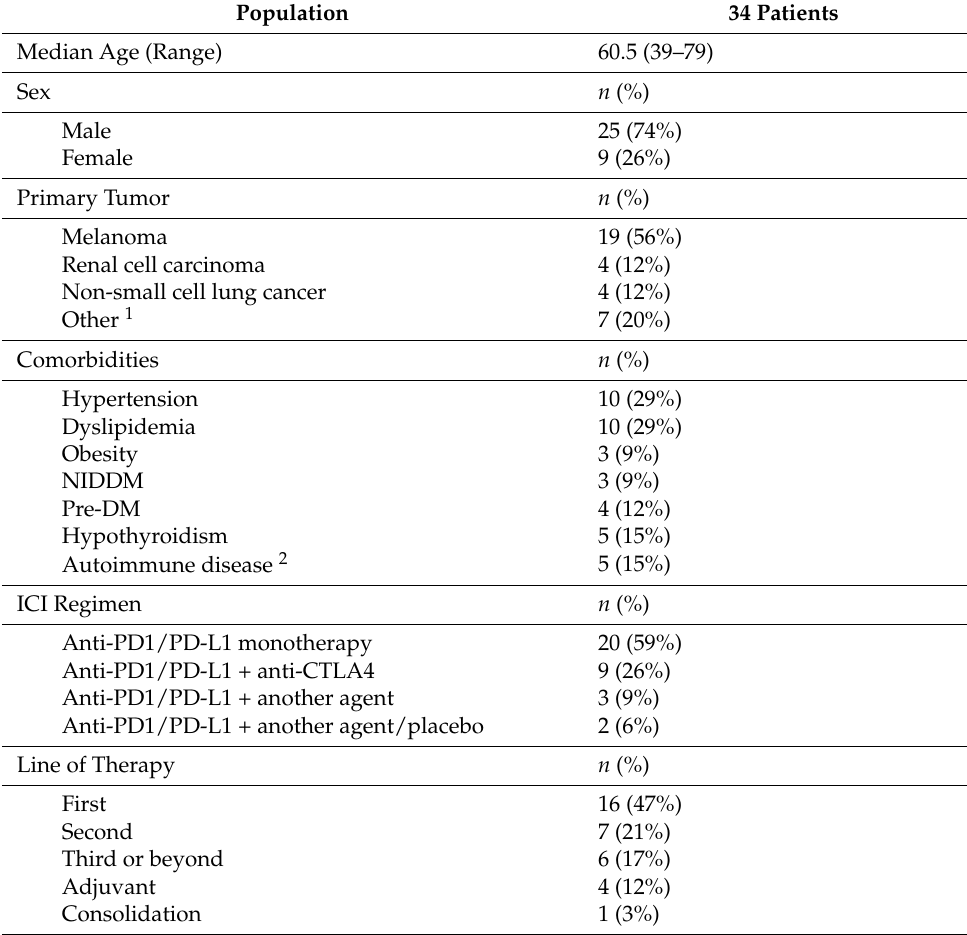
Table 1. Demographic and baseline characteristics of patients with ICI-induced